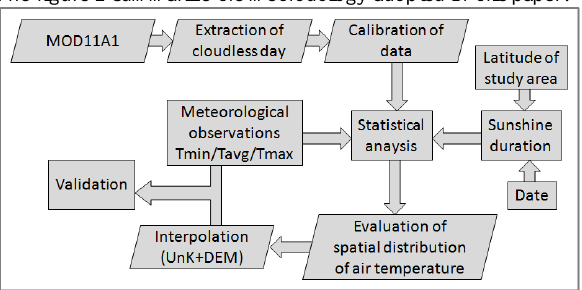
Figure 2. The processing used for estimating the daily air